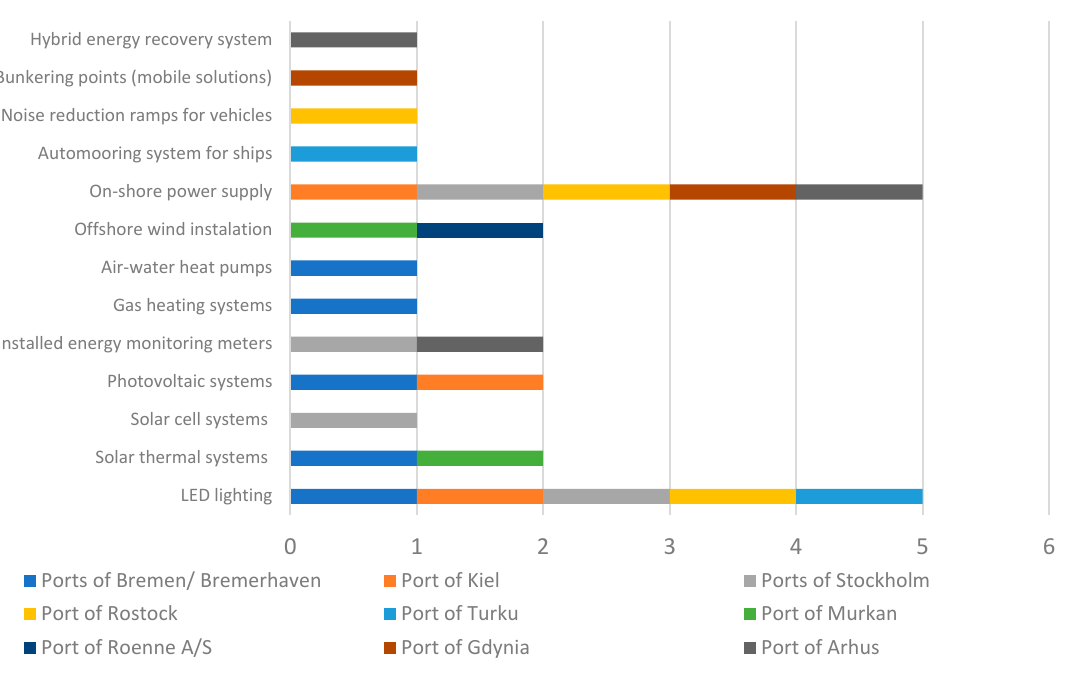
Figure 4. Pro-ecological solutions applied in the surveyed seaports in Northern Europe. Source: own elaboration on the base of: [23–27,29–39,45].